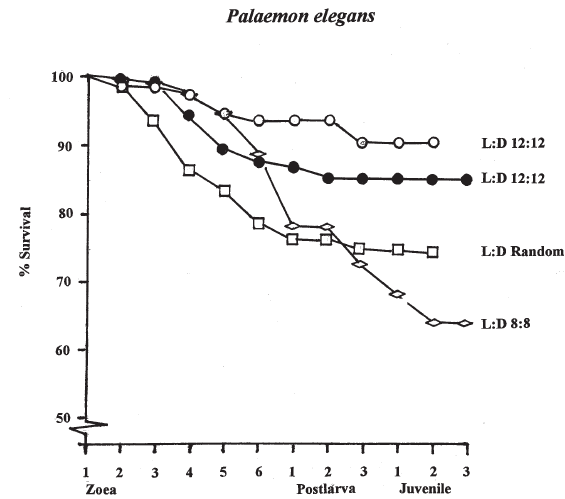
conditions (After Dalley,